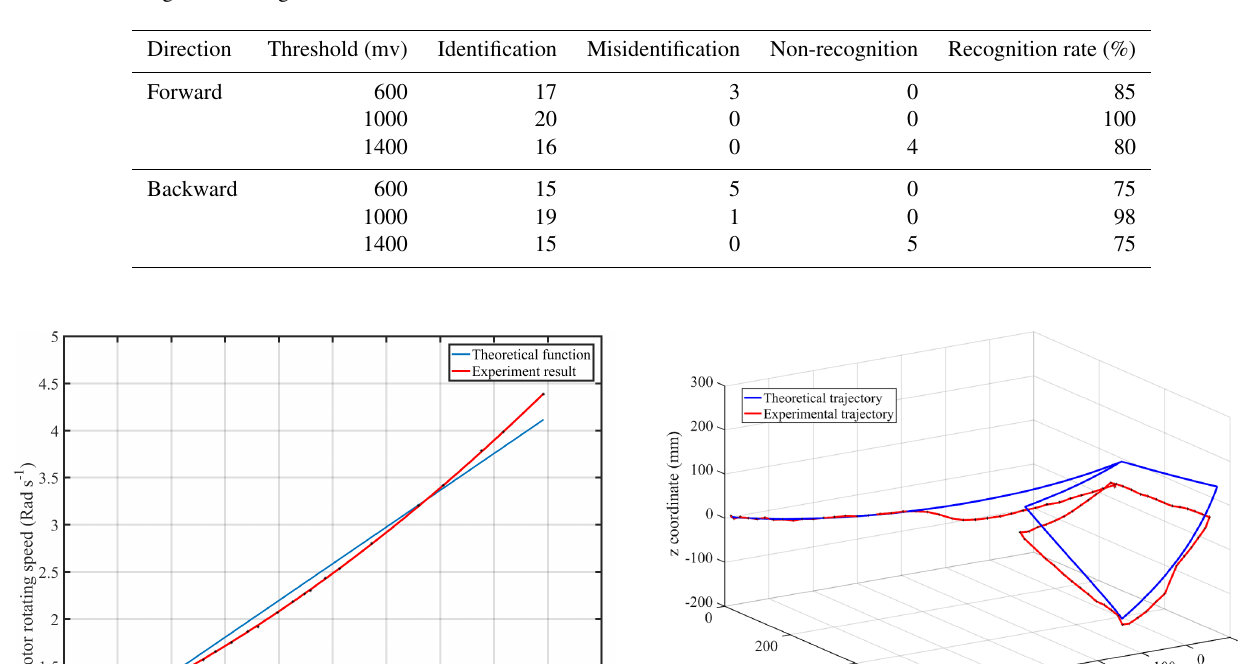
Table 1. Training action recognition in different thresholds.